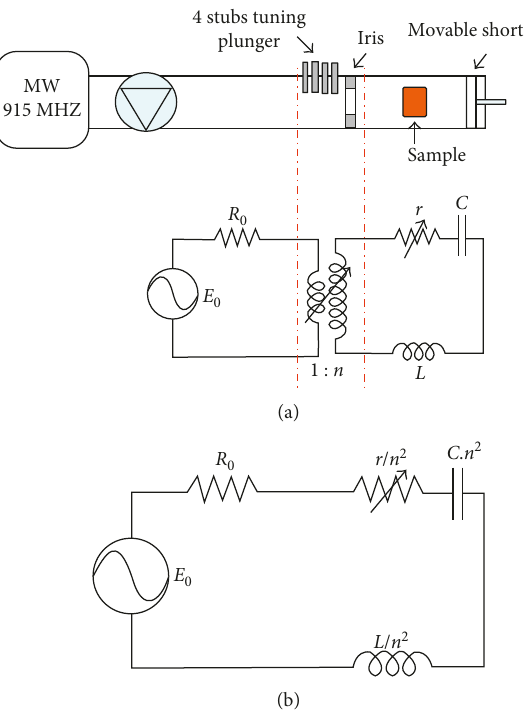
Figure 4: (a) Basic equivalent circuit of the microwave heating process. (b) Equivalent electrical circuit with load impedance referred to the primary side of the